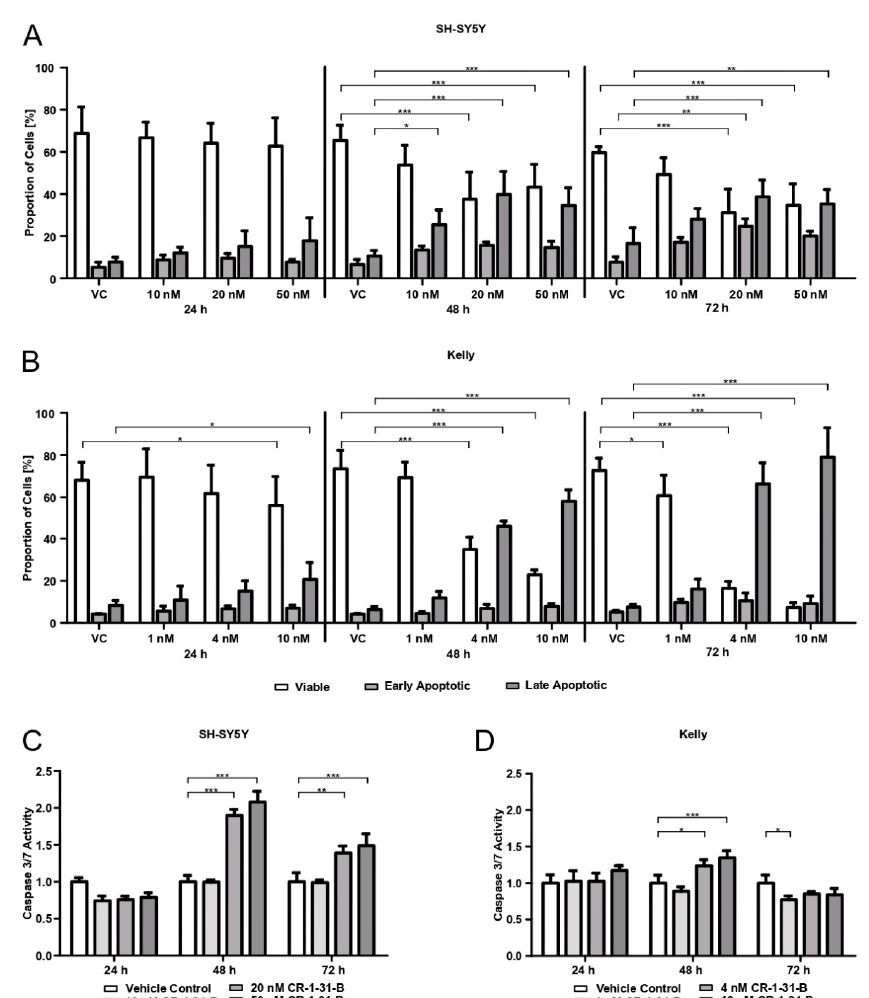
Figure 3. Targeting eIF4AI using rocaglate derivative CR-1-31-B in neuroblastoma cell lines SH-SY5Y and Kelly triggers apoptosis. SH-SY5Y cells were treated with 10, 20, and 50 nM and Kelly cells with 1, 5, and 10 nM CR-1-31-B over 24, 48, and 72 h. As a vehicle control, 0.5% (v/v) DMSO was used (VC). Apoptosis was evaluated using Annexin (Ax)/Propidium iodide (PI) staining ( A : SH-SY5Y cells; B : Kelly cells) and the detection of caspase-3/-7 activity ( C : SH-SY5Y cells, D : Kelly cells). ( A , B ) show the proportion of cells that are viable (white, Ax-/PI-), early apoptotic (light grey, Ax+, PI-), and late apoptotic (dark grey, Ax+/PI+). ( C , D ) show the activity of Caspase-3 and -7 in relation to VC. Two-way analysis of variance with Bonferroni post-hoc-test was used for statistical analysis for both tests, bars represent mean ± SEM, * p < 0.05, ** p < 0.01, *** p < 0.001, three independent experiments were performed for both